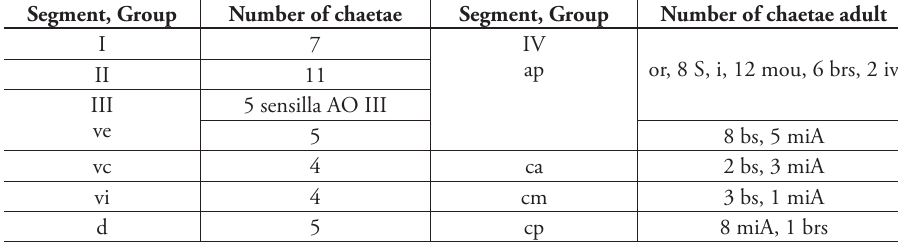
Table 2b. Chaetotaxy of Endonura paracentaurea sp. n.: chaetotaxy of antennae. Segment, Group